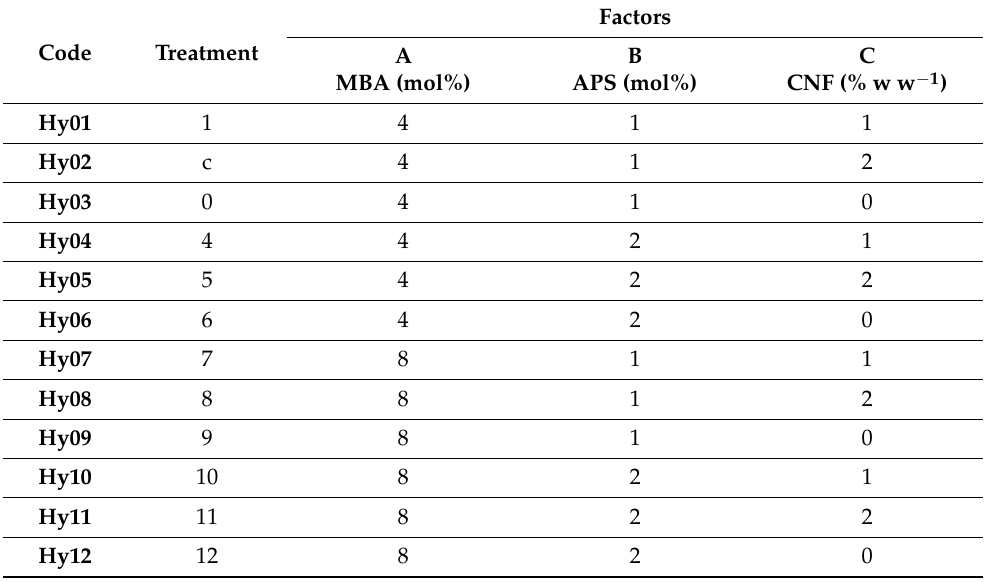
Table 2. Experimental design matrix (2 × 2 × 3 → 12) for the synthesis of ion exchange hydrogels. Treatment “c” indicates that the lowest level of testing has been